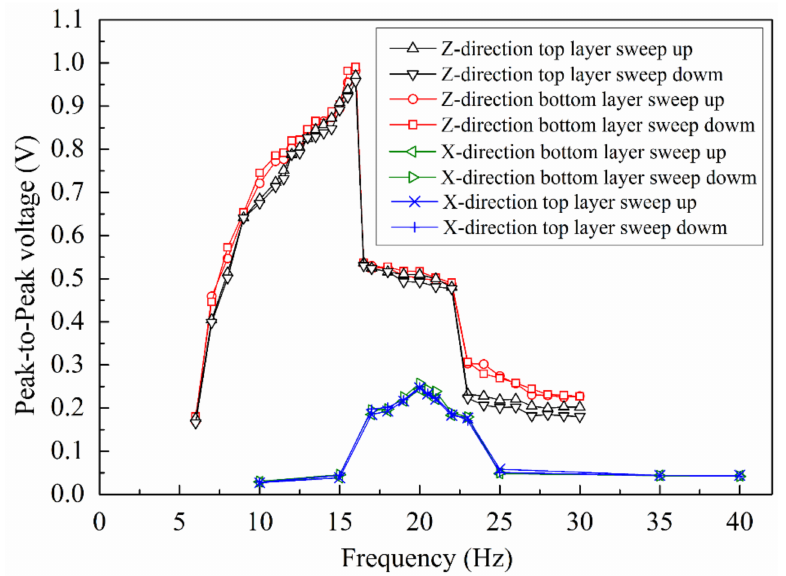
Figure 7. The frequency-dependent open-circuit output voltage of the EVEH in both top and bottom coils, on both Z and X